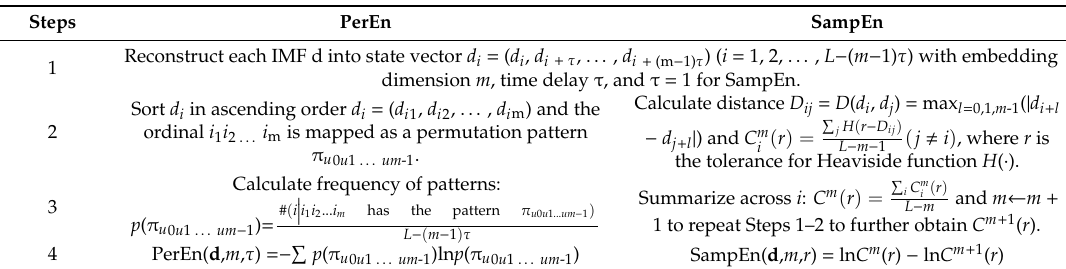
Figure 1. Framework of the proposed multi-fault diagnosis method for rolling bearings. Table 1. Procedures for calculation of PerEn and